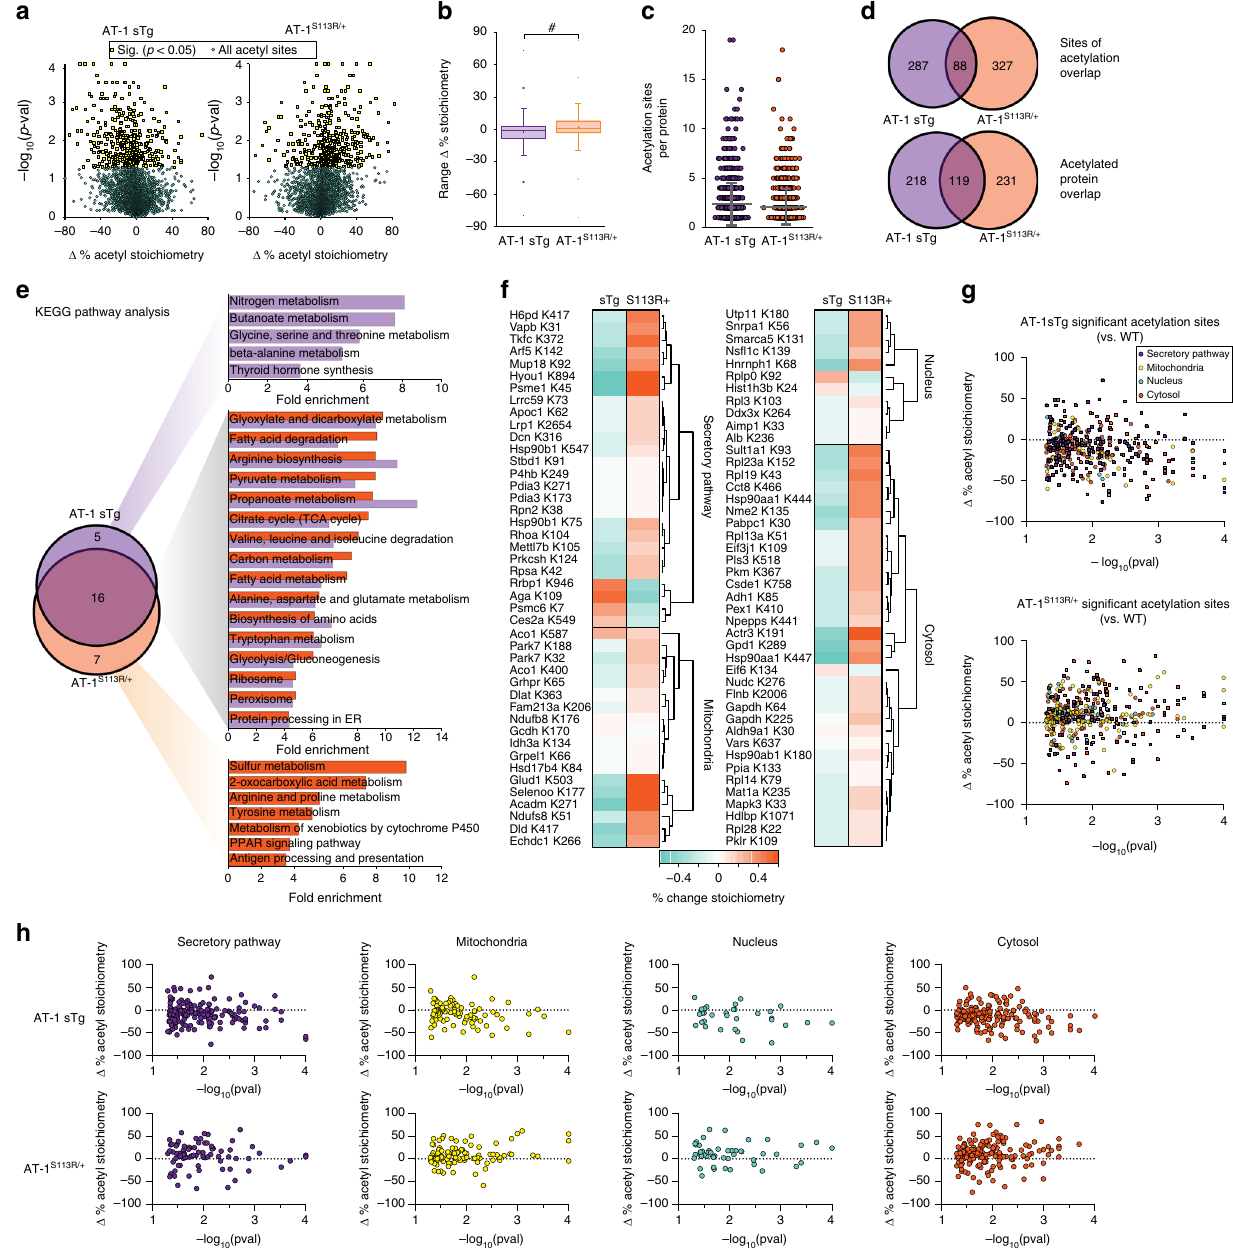
Fig. 3 AT-1 sTg and AT-1 S113R/ + mice show changes in stoichiometry of lysine acetylation across many metabolic pathways. a Volcano plot of percent change in lysine acetylation sites detected in AT-1 sTg ( n = 4; left) and AT-1 S113R/ + ( n = 4; right) mice, compared with age-matched WT littermates. Statistically signi fi cant sites (375 in AT-1 sTg; 415 in AT-1 S113R/ + ) are highlighted in yellow, and all other detected sites are designated in blue. One-way ANOVA, P < 0.05. b Percent change of lysine site stoichiometry of all detected lysine sites in both models of AT-1 dysregulation. The data represented as box and whisker plots: box represents 25th to 75th inner quartile range; middle line denoting the median, and the inner square denoting the mean; whiskers represent the interquartile distance with a coef fi cient of 1.5; the most extreme values are the minimum and maximum, and the other dots are the 99th percentile and 1st percentile. Kolmogorov – Smirnov test. # P < 0.0005. c The number of acetylation sites affected per protein. d Venn diagram showing the overlap between signi fi cant lysine sites (upper) and the overlap between acetylated proteins (lower) in AT-1 sTg and AT-1 S113R/ + mice. e Venn diagram of enriched KEGG pathways, and their enrichment scores found in models of AT-1 dysregulation. Purple denotes AT-1 sTg, and orange denotes AT-1 S113R/ + . Parameters for enrichment can be found in the Methods section. f Heatmap showing the percent change in stoichiometry of the 88 overlapping sites found in both models. Subcellular localization was determined according to the Uniprot database annotation. The secretory pathway includes the endoplasmic reticulum, Golgi apparatus, proteasome, lysosome, extracellular, and secreted proteins. Cytoplasm includes the cytoskeleton, cytosol, ribosomes, and all other organelles. g, h The distribution of signi fi cant lysine acetylation sites according to their Uniprot subcellular annotation, as a global view in AT-1 sTg (upper) and AT-1 S113R/ + (lower) mice ( g ), and arranged by localization: the secretory pathway (purple circles), mitochondria (yellow circles), nucleus (blue circles), and cytosol (orange circles) ( h ). The original data set is shown in Supplementary Data 2. All sites analyzed in d – h were signi fi cantly different ( P < 0.05, one-way ANOVA) from age-matched WT littermates. Bars are mean ± s.d. Circles indicate the average value of each acetylation